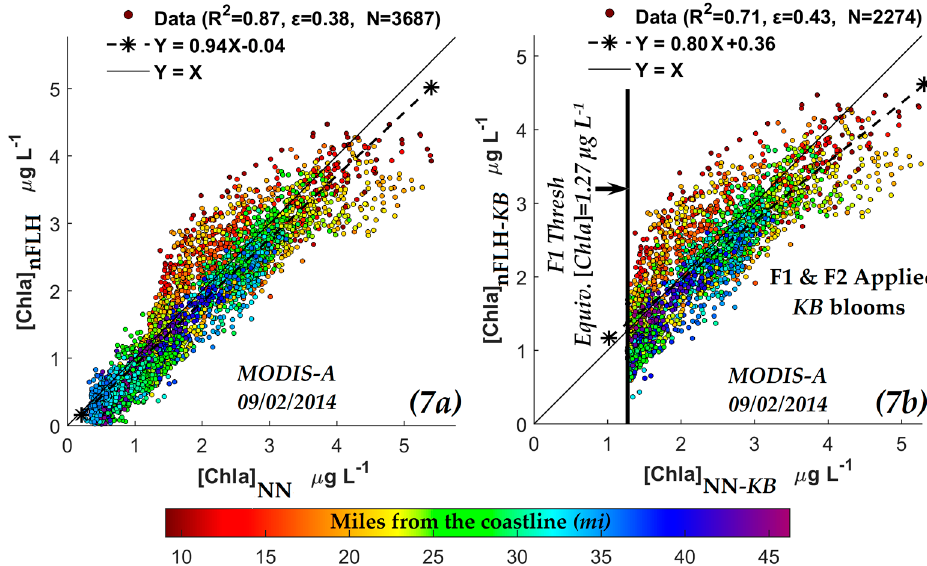
Figure 7. ( a ) MODIS-A nFLH equiv. [ Chla ] retrievals against MODIS-A NN equiv. [ Chla ] retrievals; ( b ) Shows the same retrievals as 5a but with F1 and F2 masks applied. Color coding of the dots denotes distance to shore, with red being the closest.